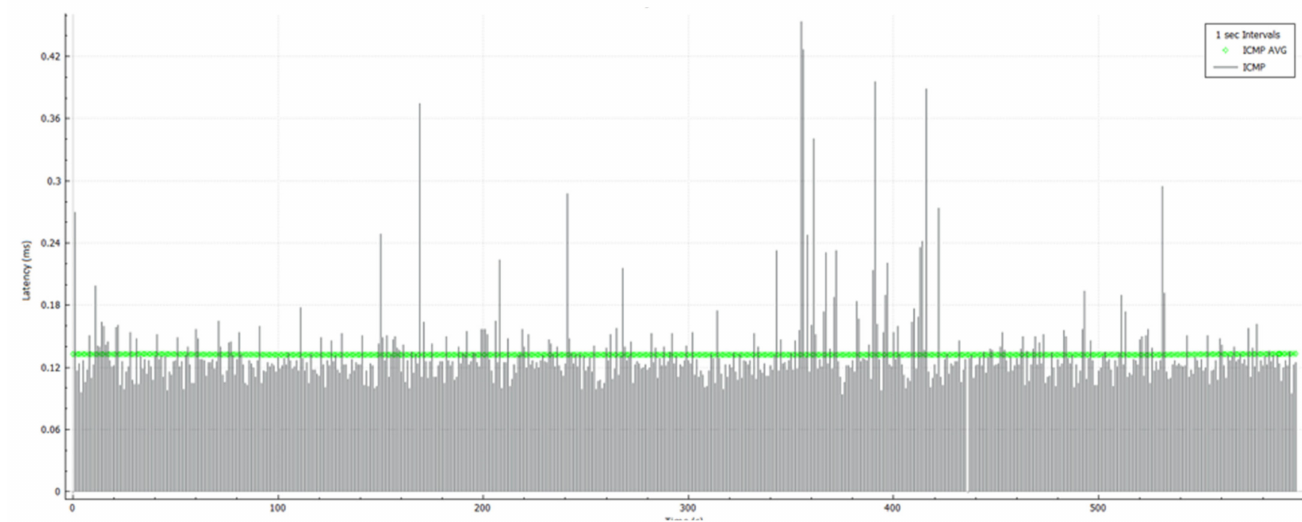
Figure 7. 5G gNB FR1 OTA RF latency measured using an EMITE F200 reverberation